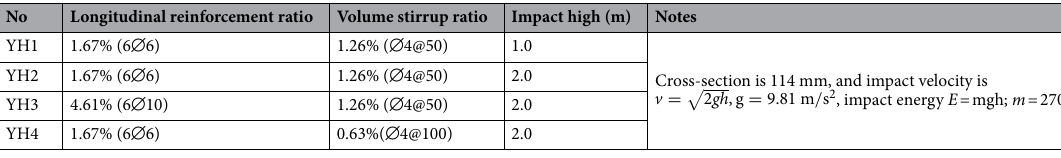
Table 1. List of concise specimen